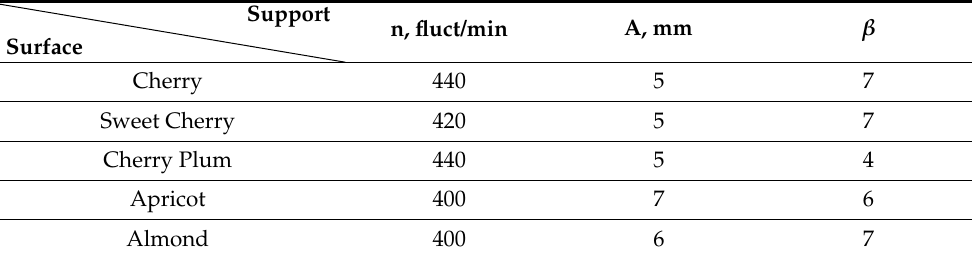
Table 4. Optimal parameters and operating modes laboratory installation for the calibration of fruit